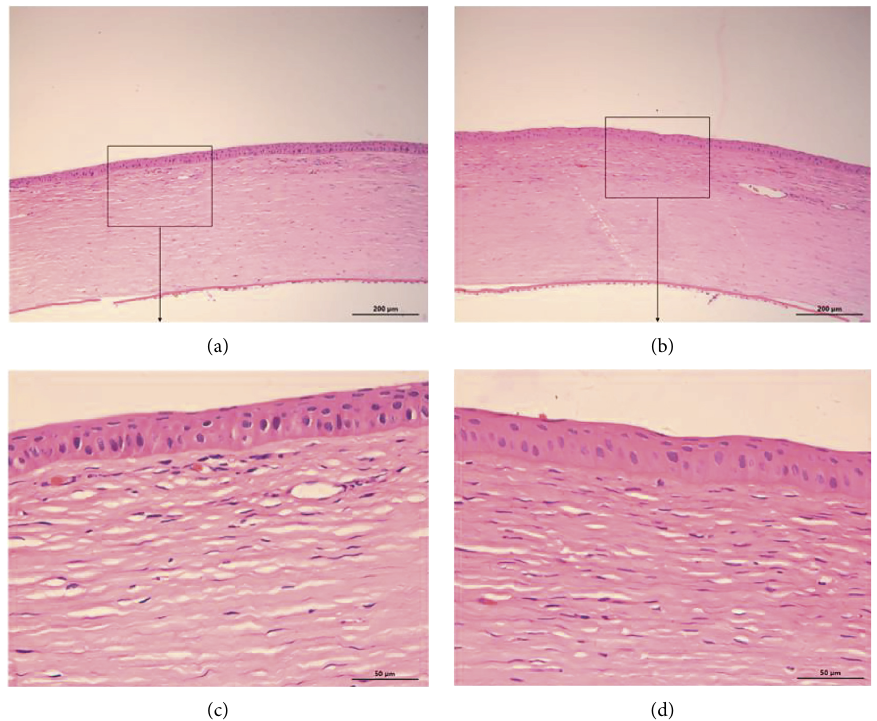
Figure 5: Histopathology of corneas in each group 28days after CXL. The corneal tissue of rabbit in each group was subject to HE staining. Figure (a) and (c) accelerated CXL group; Figure (b) and (d) standard CXL group. Figure (c) and (d) (X40) are the magnification of the content of the boxes in figure (a) and (b) (X10), respectively.